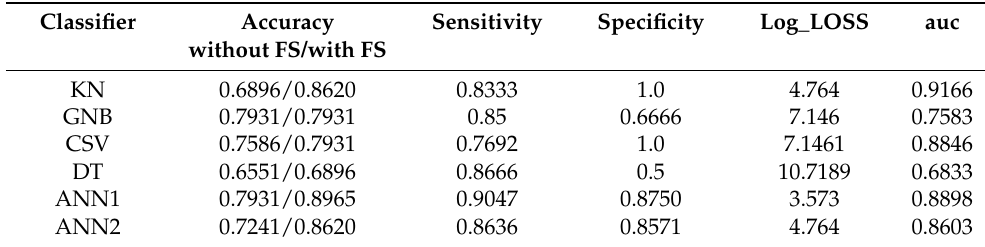
Table 3. Performance results by classifier; KN: K-Neighbors; GNB: Gaussian Naive Bayes; CSV: C-Support Vector; DT: Decision Tree; ANN1: Artificial neural network with a single hidden layer;